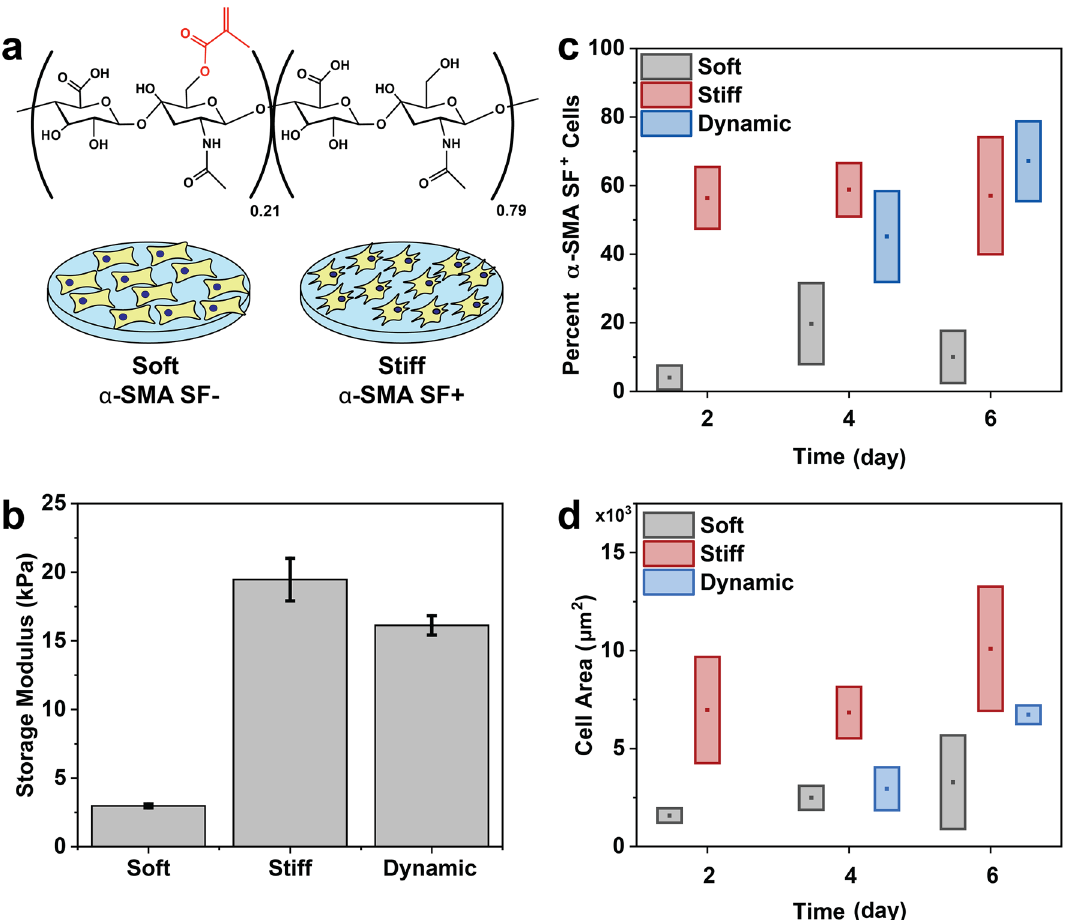
Figure 2. ( a ) Structure of methacrylated hyaluronic acid (MeHA) polymer for hydrogels. Cardiac fibroblasts were cultured on stiff substrates to promote α-SMA stress fiber organization. ( b ) Storage moduli for soft, stiff, and dynamic hydrogels as measured by shear oscillatory rheometry. ( c ) More cells display α-SMA stress fiber organization when cultured on stiff substrates, even when initial culture begins on soft substrates (as in the dynamic condition). ( d ) Cell area increases after at least two days of culture on stiff substrates. Boxes are ± 1 standard deviation; detailed statistics are shown in Tables S1 and